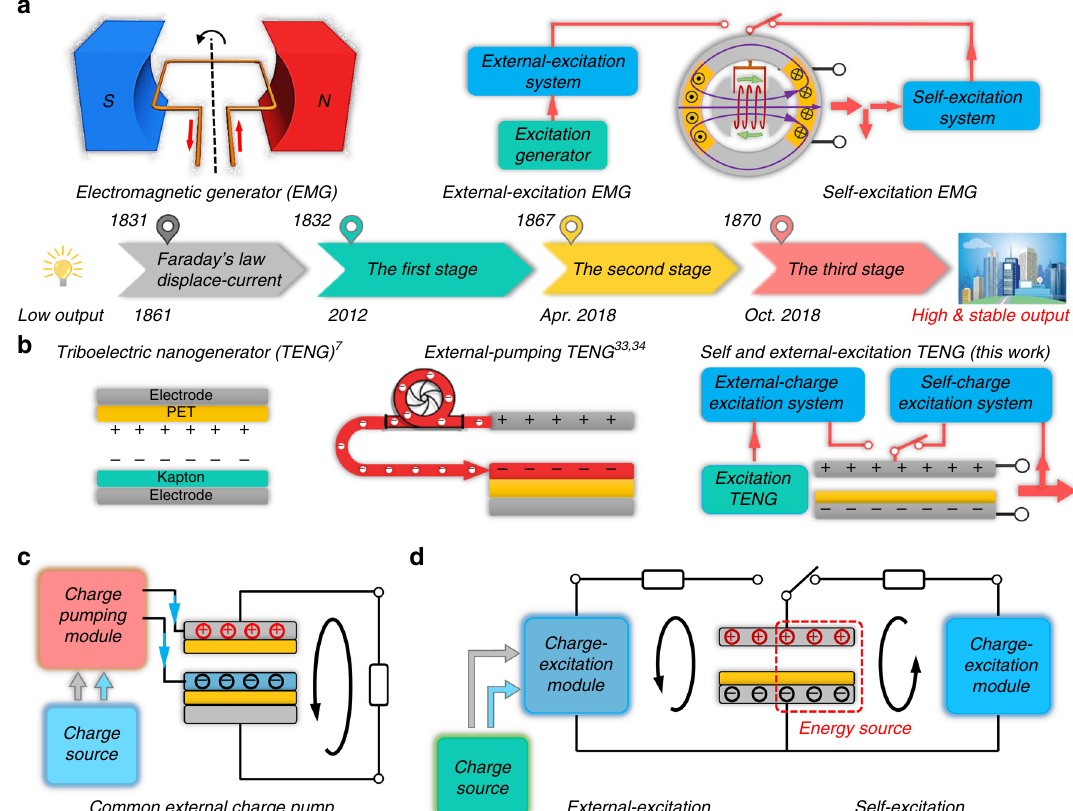
Fig. 1 Historical development stages of mechanical energy converting device. a The development of electromagnetic generator (EMG) from faraday ’ s law to self-excitation EMG. b The development of triboelectric nanogenerator (TENG) from Maxwell displacement current to self-excitation TENG. c The fundamental system scheme of traditional external charge pump methods for improving the output density of TENG. d The fundamental scheme of both external and self-charge excitation TENG proposed in this